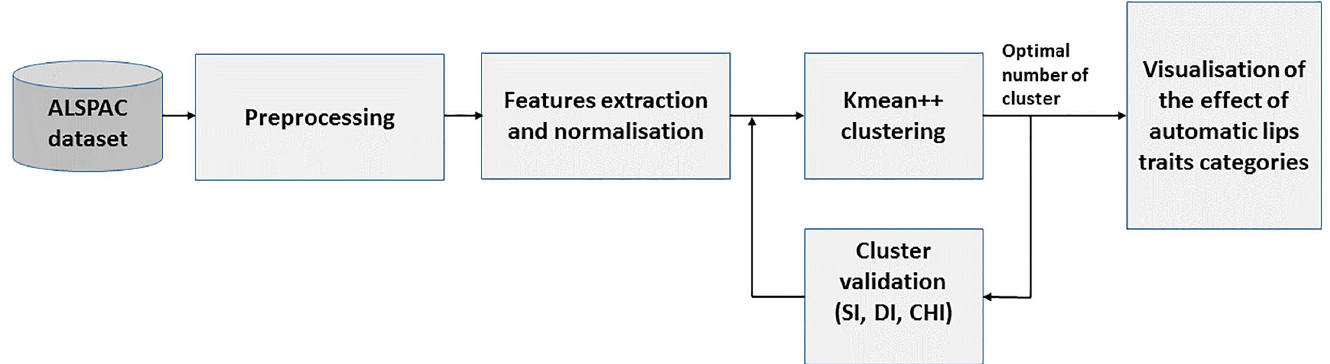
Fig 5. Categorisation block diagram. This diagram illustrates the proposed approach for automatic categorisation lip